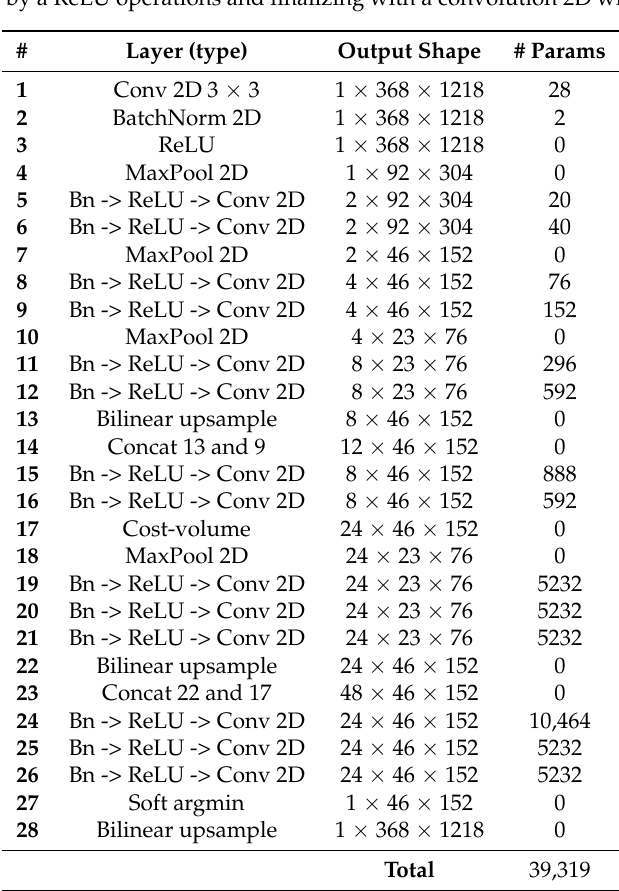
Table 6. Proposed model configuration. Bn -> ReLU -> Conv 2D corresponds to BatchNorm 2D operation followed by a ReLU operations and finalizing with a convolution 2D with kernel size